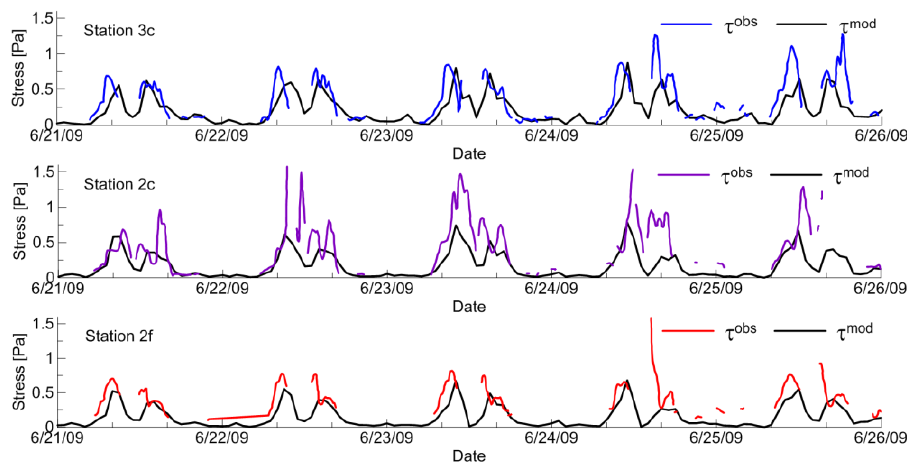
Figure 6. Comparison of observed bottom stress in Skagit tidal flats shown at stations 3c, 2c and 2f during June of 2009 as part of sediment model setup and calibration. (τ obs = observed bottom shear stress and τ mod = modeled bottom shear stress).